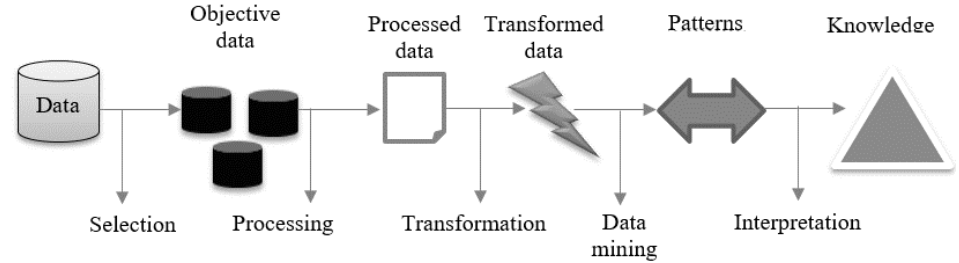
Figure 4. Knowledge discovery in databases (KDD).